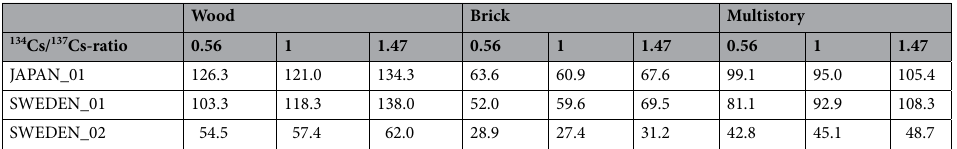
Table 4. Averted collective dose by evacuation and 5 cm topsoil removal at t cleanup = 1 y for indoor occupancy per unit area and deposition of 137 Cs (manSv km -2 )/(MBq m -2 137 Cs) in three typical residential areas for different 134 Cs/ 137 Cs ratios and for the three different soil migration parameters given in Table 2. Average population densities in one-story buildings and high-rise building areas are assumed to be 2140 inhabitants km -2 and 11,600 inhabitants km -2 , respectively.